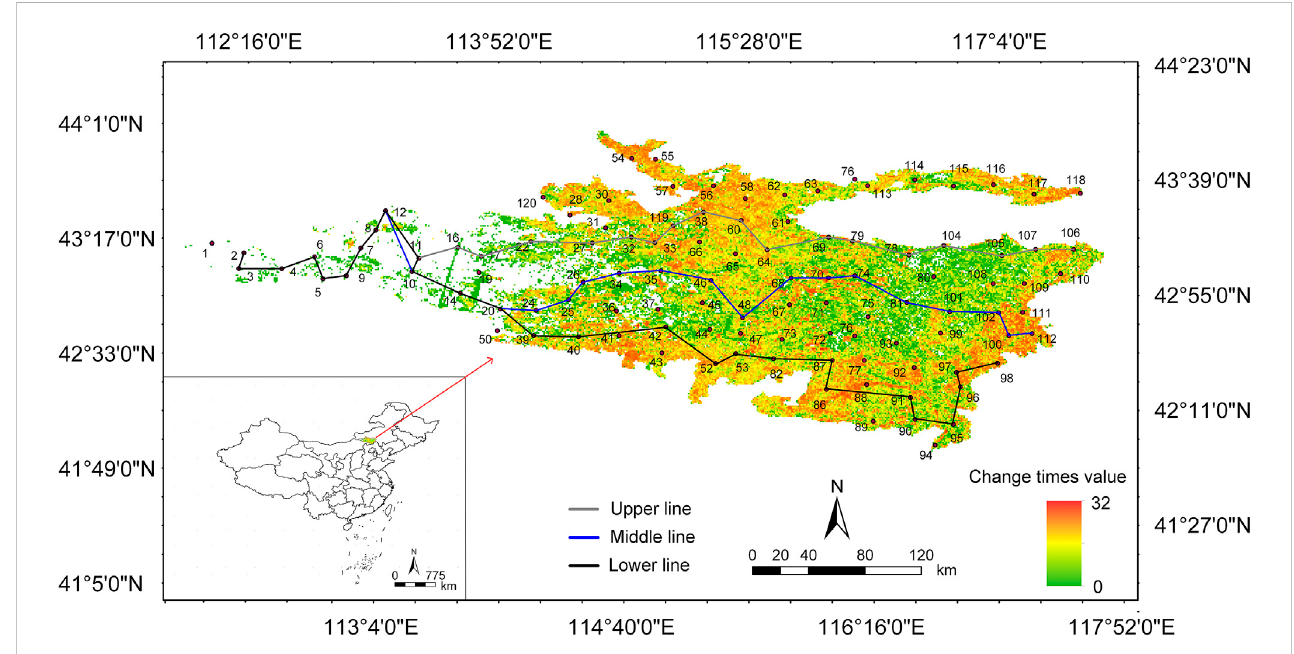
FIGURE 1 Distribution of vegetation type change times in the Otindag Sandy Land over 36